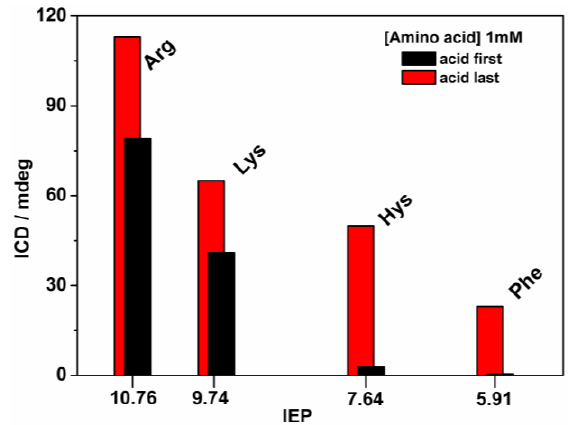
Figure 6. Intensity of the iCD at 489 nm (absolute value) versus the isoelectric point (IEP) of the amino acids for both procedures: “ acid first ” (represented by the black bars) and “ acid last ” (represented by the red bars).